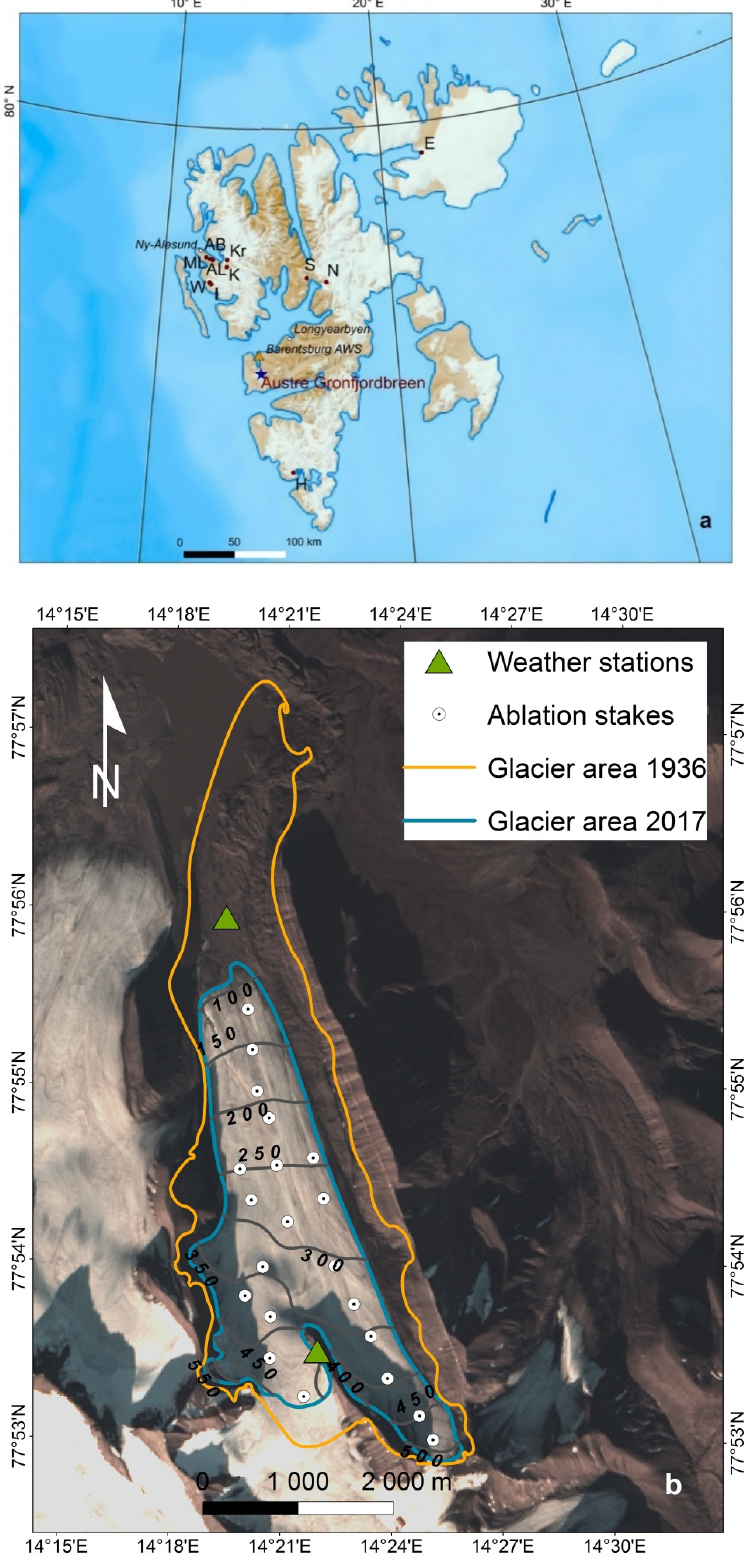
Figure 1. ( a ) Glaciers with ongoing mass balance measurements on Svalbard (Table 6). The map is provided by © Norwegian Polar Institute (npolar.no) [23]; ( b ) observation network on Austre Grønfjordbreen. The background is a Landsat image (14 September 2017). The glacier outline of 1936 is delivered by the CryoClim service with the © Norwegian Polar Institute (npolar.no) [24].